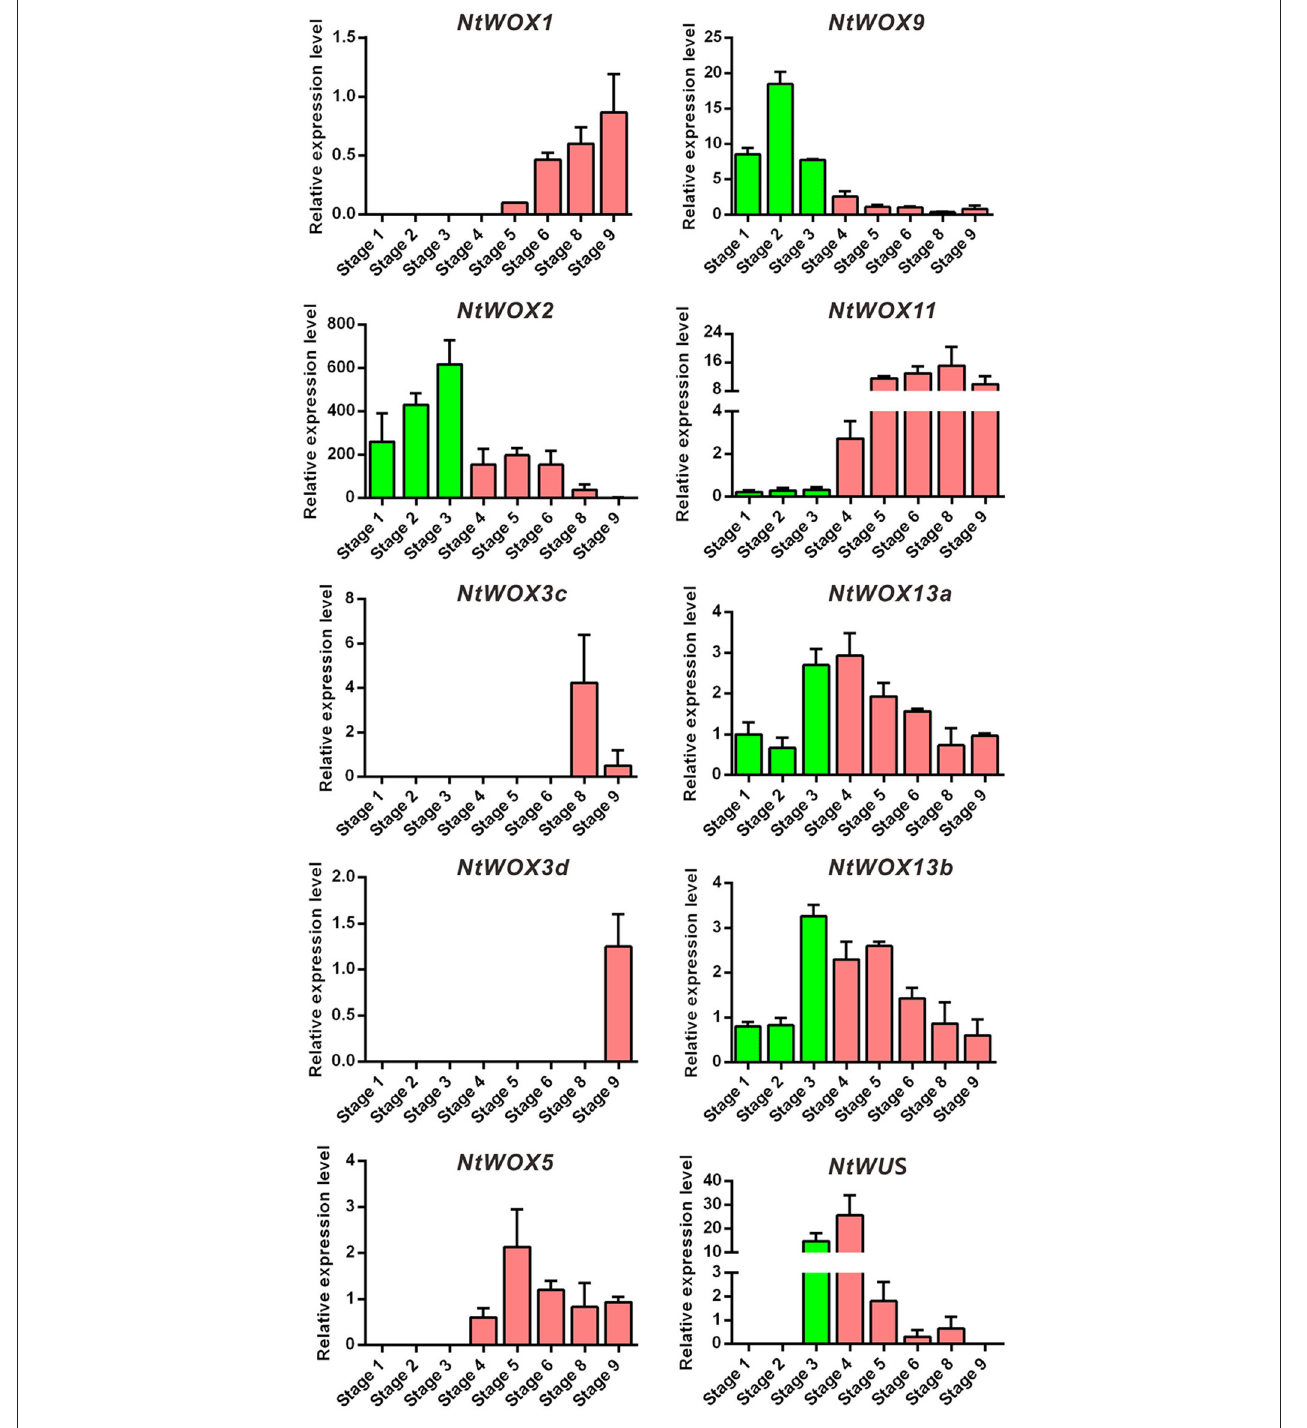
FIGURE 3 | Stage-specific expression pattern of WOXs during the process of embryogenesis. The expression level of each WOX in embryo at stages 9 (except WUS ) was set as 1. The expression level was normalized to the average expression level of GAPDH (AJ133422), polyubiquitin (GQ281244), and elongation factor 1 α (AF120093). Error bars represent mean ± standard error from three independent experiments. Nine successive stages of embryogenesis were classified in tobacco as described previously (Zhao et al., 2013).